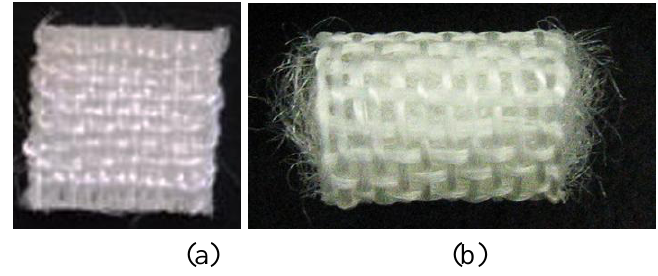
Figure 5. Three-dimensional scaffolds fabricated with the chitosan-based HA hybrid polymer fibers: ( a ) cushion-type scaffold, ( b ) cylinder-type